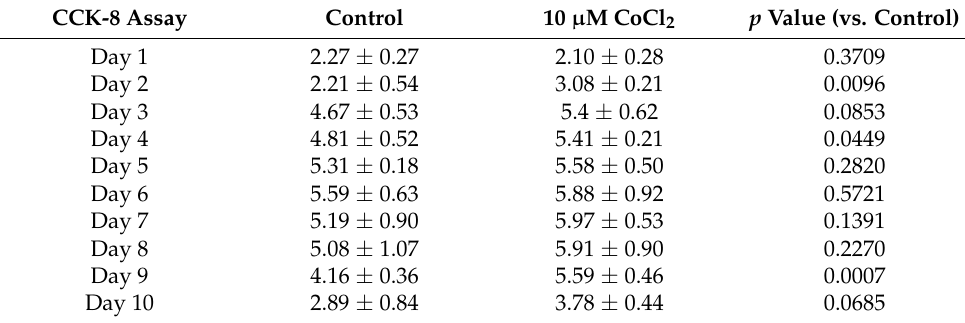
Figure 2. ( A ) : Chronological evaluation of absorbability; ( B ) : PCR results. ns not significant, * p < 0.05, and ** p < 0.01. Table 3. Effect of CoCl 2 on proliferation.